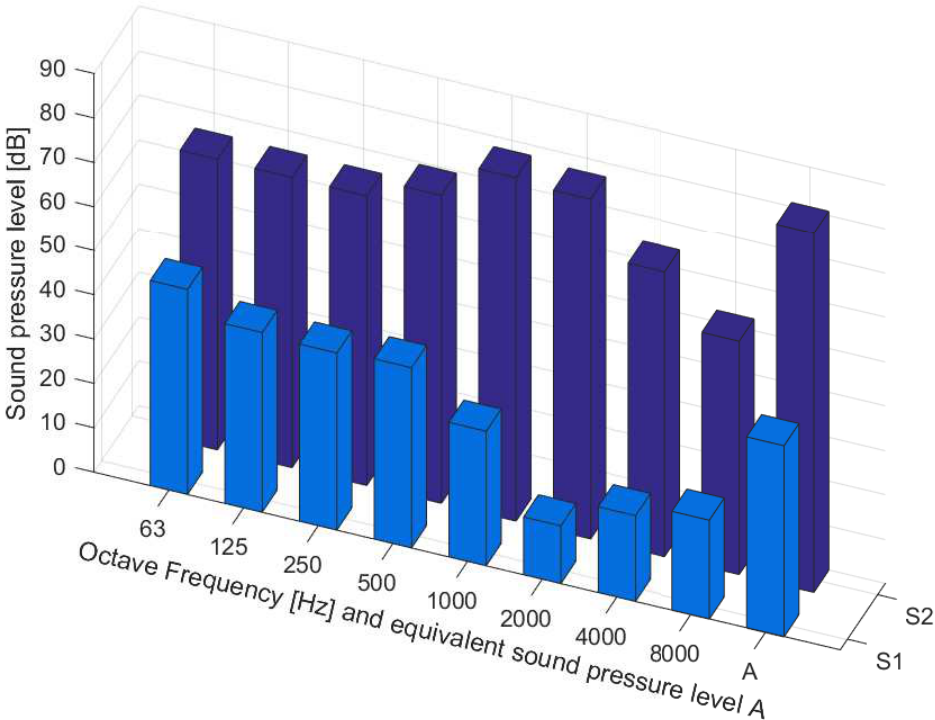
Figure 23. Sound pressure level in octave bands and equivalent sound pressure level A: dark blue—passenger car crossing, light blue—acoustic